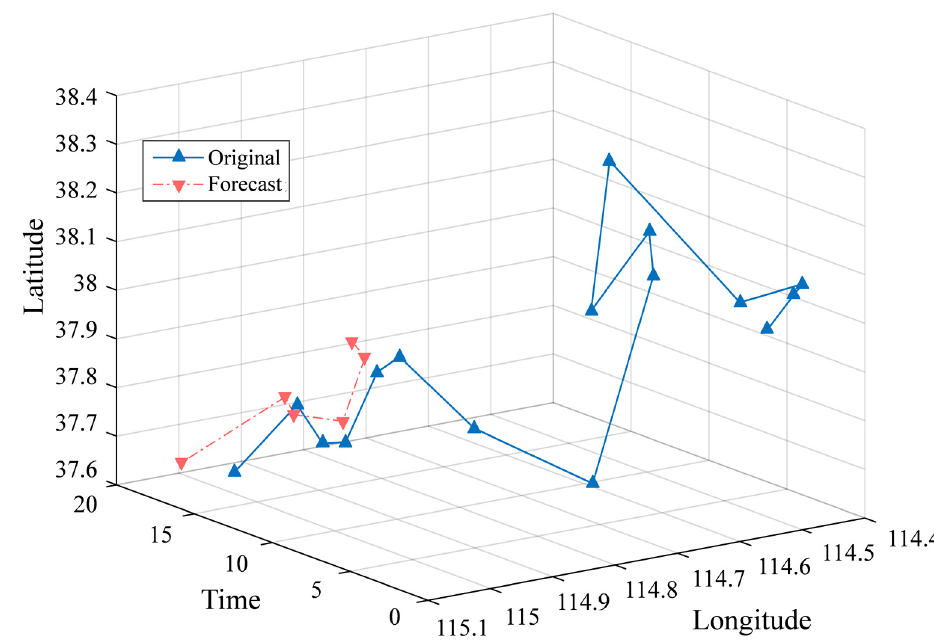
Figure 12. Comparison diagram of pedestrian predicted trajectory.